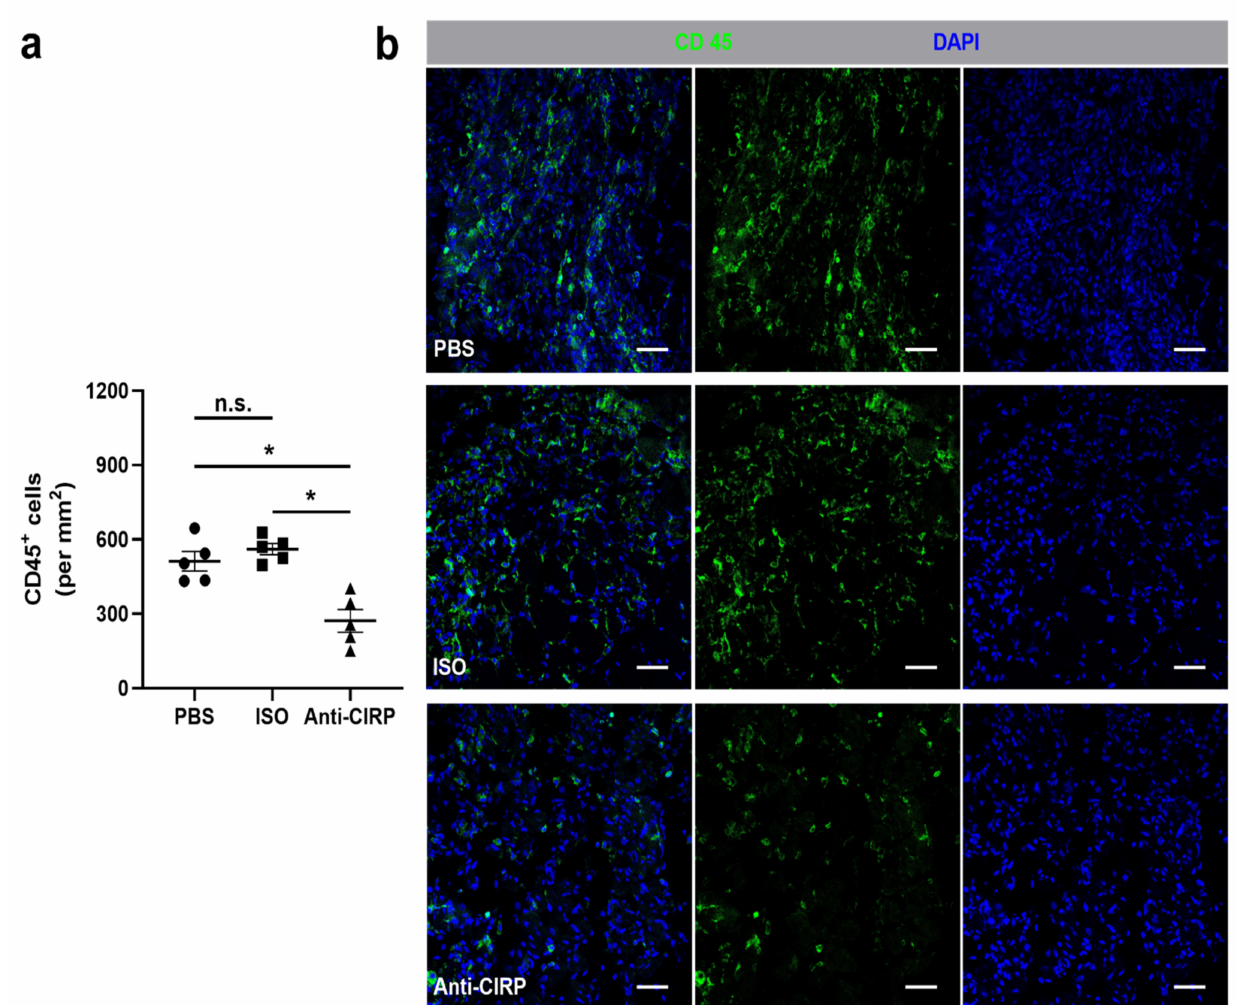
Figure 2. Neutralization of extracellular “Cold-inducible RNA-binding protein” (eCIRP) decreases leukocyte accumulation in ischemic tissue. ( a ) The scatter plot displays the relative number of CD45 + (pan-leukocyte marker) cells (per mm 2 ) in the ischemic gastrocnemius muscles of mice that received phosphate-buffered saline (PBS), isotype antibody (ISO) (control groups), or the anti-CIRP antibody (Anti-CIRP) and were sacrificed 7 days after femoral artery ligation (FAL). Data are means ± S.E.M., n = 5 per group. n.s. p > 0.05, * p < 0.05 (PBS vs. ISO vs. Anti-CIRP) by one-way ANOVA with the Tukey’s multiple comparisons test, a defined ischemic area (1.5 mm 2 ) of muscle tissue was analyzed per mouse. ( b ) Representative immunofluorescence staining of ischemic gastrocnemius muscles of mice treated with PBS (top), isotype antibody (middle), or anti-CIRP antibody (bottom) 7 days after FAL. Cells were stained with an antibody against CD45 (green) and DAPI (blue) to label nucleic DNA. Scale bars represent 50 µ